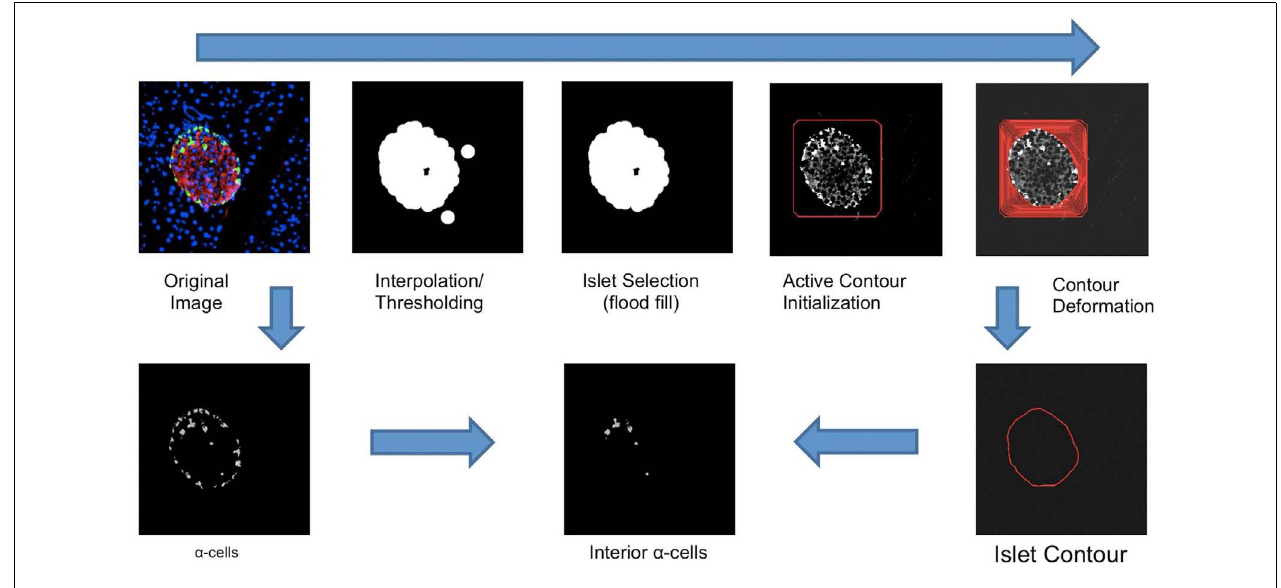
interpolation of contour points. Interior alpha-cells were determined by the distance between each alpha-cell centroid and the nearest point in the surrounding islet